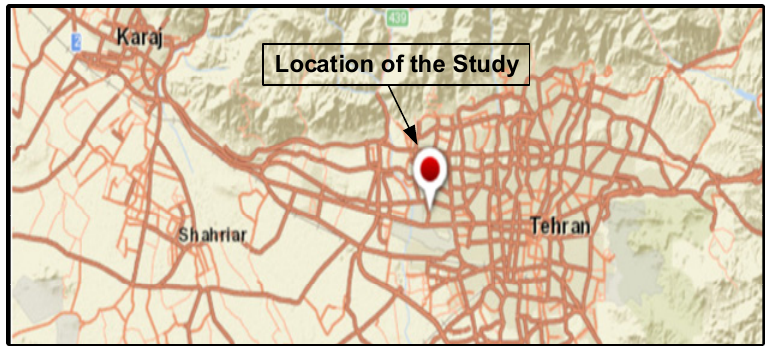
Figure 3. The location of the understudy residential household in Tehran, Iran.